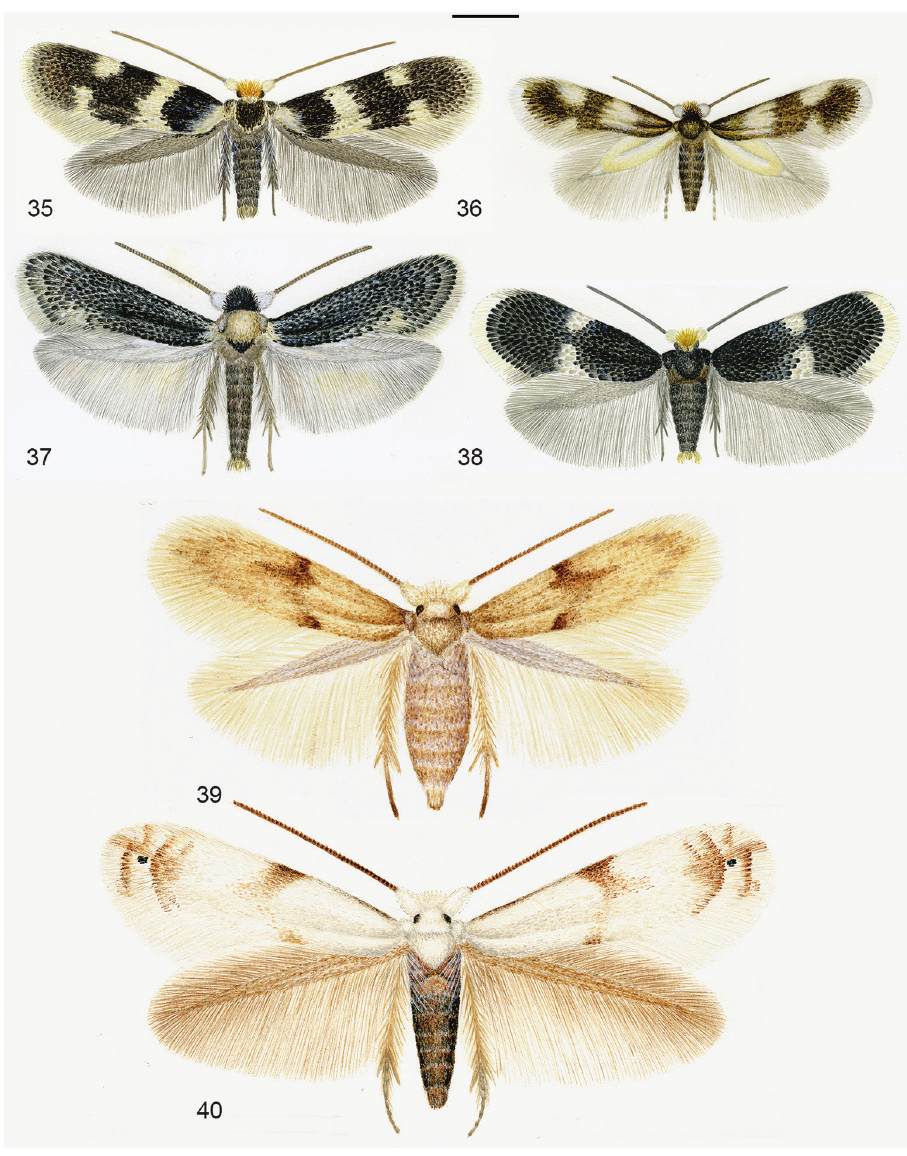
Figures 35–40. Diversity of Nepticulidae and Opostegidae, all on same scale. 35 Etainia sericopeza , male, Sweden 36 Acalyptris platani , male, Italy 37 Zimmermannia atrifrontella , male, Germany 38 Ectoedemia klimeschi , male, Austria 39 Opostega spatulella , female, Hungary 40 Pseudopostega crepusculella , male, Sweden. Scale 1 mm. Watercolours by Roland Johansson, published earlier by Johansson et al. (1990). These figures may be reproduced given that their author Roland Johansson and the present publication are